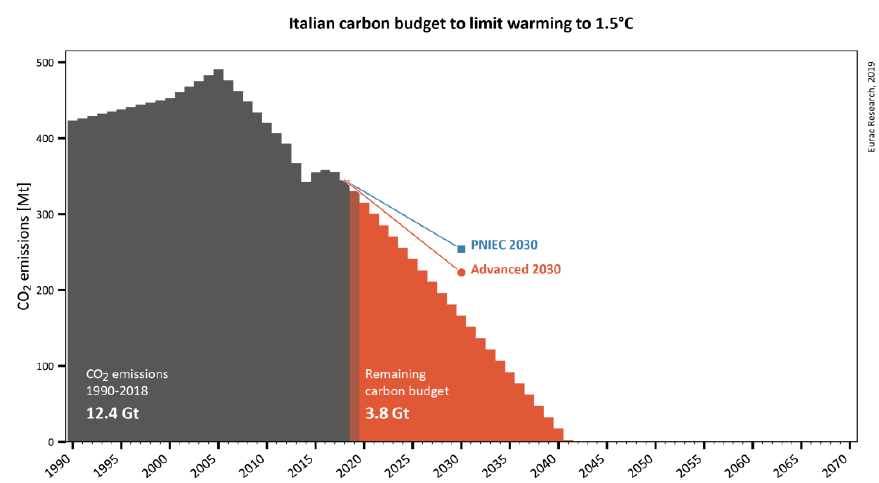
Figure 14. CO 2 emissions historical data and comparison between the PNIEC 2030, Advanced 2030 scenarios and the scenario defined by the remaining carbon budget.